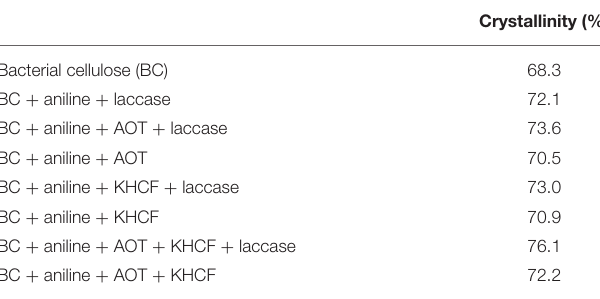
TABLE 2 | Cellulose crystallinity of BC/PANI samples.